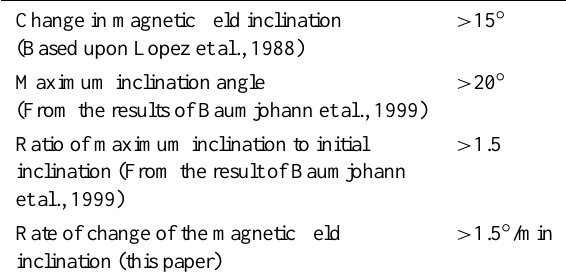
Fig. 1. Orbital trajectories of the Wind spacecraft in the X − Y plane for 1995 to 2000. The trajectory is shown only when X< 0 R E and − 6 R E <Z< 6 R E . Table 1. Dipolarization event selection